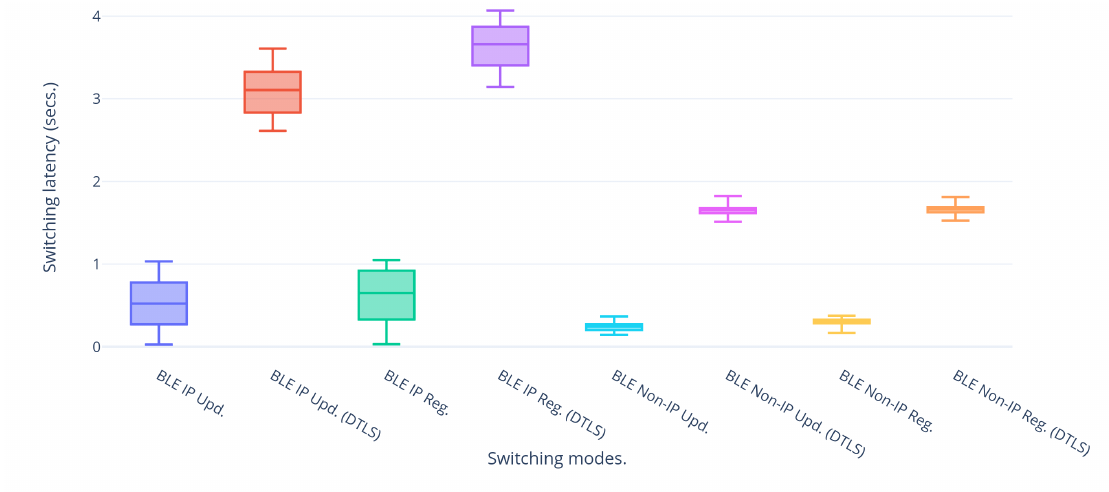
Figure 6. Handover latencies of BLE with(out) Datagram Transport Layer Security (DTLS).